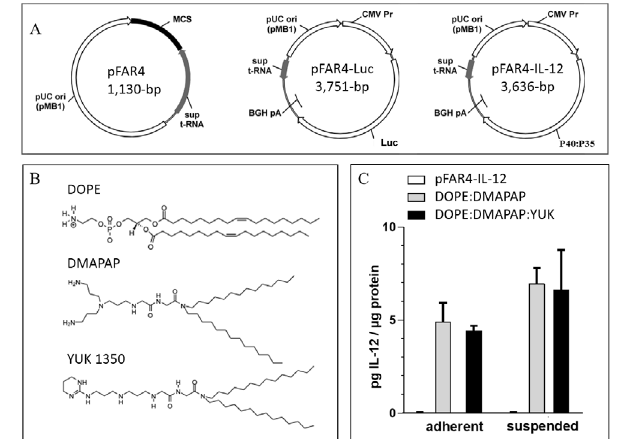
Figure 1. Lipid and plasmid used and their transfection efficiency. (A) Maps and plasmid sizes of pFAR4, pFAR-Luc, and pFAR4-IL-12 containing the Luc and IL-12 expression cassette introduced into the MCS of the pFAR4 gene vector. (B) Chemical structure of the lipids used DOPE, DMAPAP, and YUK1350 in the liposomal composition. (C) Transfection efficacy of adherent or suspended CT26 cells using either naked pFAR4-IL-12, DOPE/DMAPAP, or DOPE/DMAPAP/YUK1350 containing lipoplexes at a dose of 1µg plasmid/well and a charge ratio N/P = 6. After 24 h, transfection efficiency was assessed by quantifying secreted IL-12 levels normalized by total intracellular proteins. The data given are averages of triplicates. bar ± SEM. pUC ori: origin of replication of pUC-type; sup t-RNA: suppressor t-RNA; BGH pA: bovine growth hormone polyadenalytion signal; CMV Pr: CMV